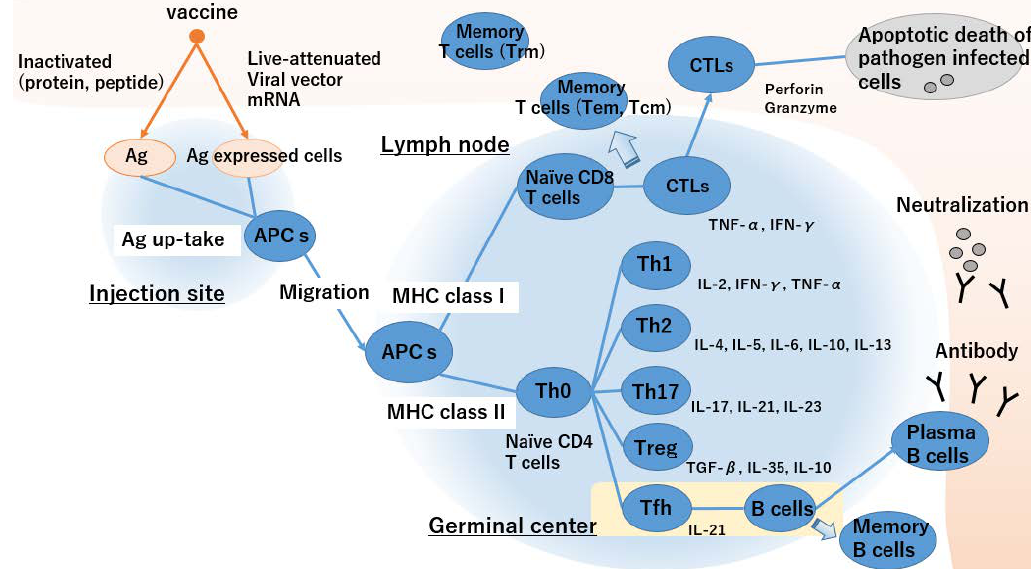
Figure 1. Generation of humoral and cellular immunity by